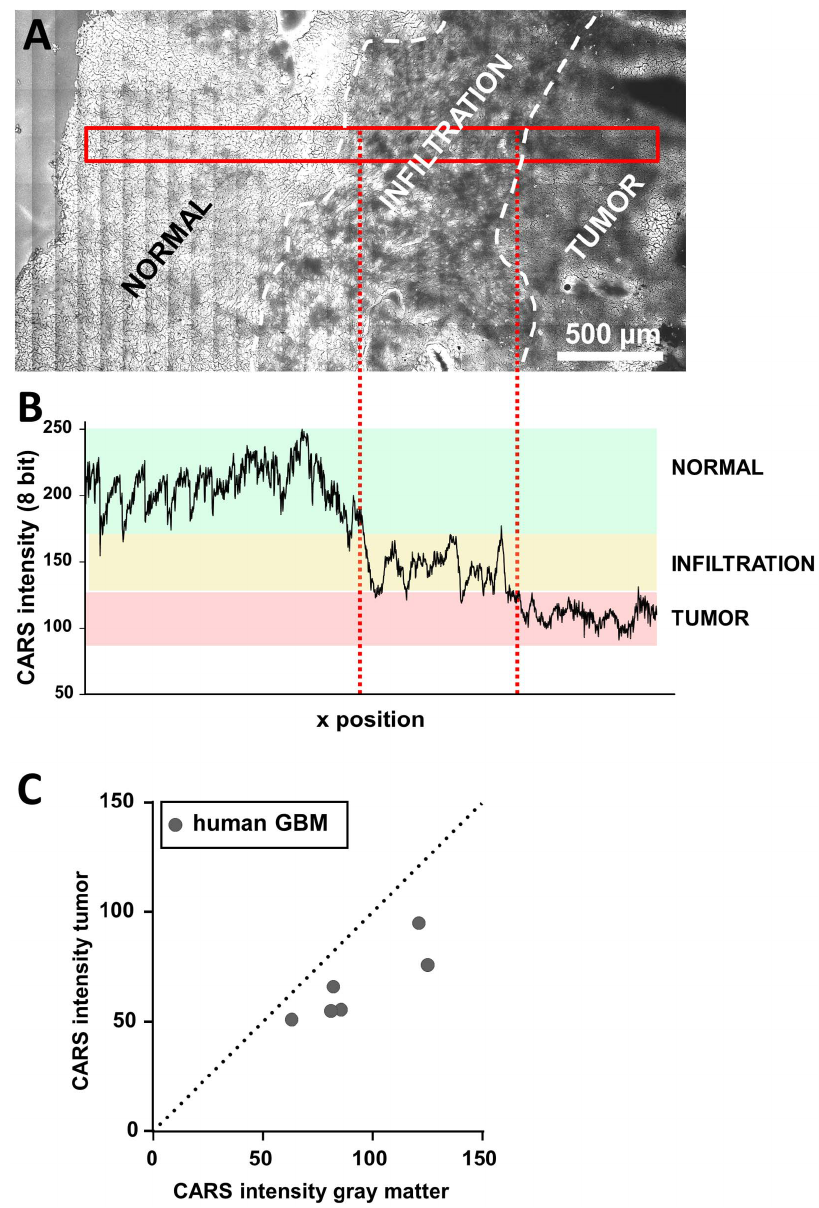
Figure 6. Quantification of the CARS signal in human GBM. A : Unprocessed CARS image of a cryosection of a human GBM specimen obtained during routine surgery. The CARS image displays the margin of a solid tumor and an infiltrative region. B : CARS signal intensity along the area indicated in panel A. The range of CARS signal intensity of normal tissue is underlined in green, of infiltrative areas in yellow, and of tumor in red, respectively. C : Dot plot showing the CARS signal intensity in normal gray matter vs. the intensity of the CARS signal in human GBM for each sample.